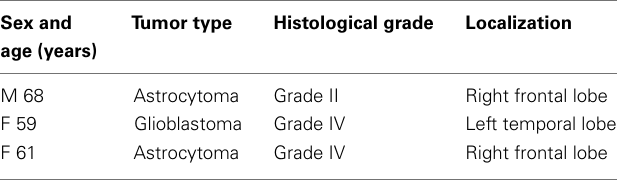
Table 1 | Clinical and histological characteristics of the glial tumors used in the study.